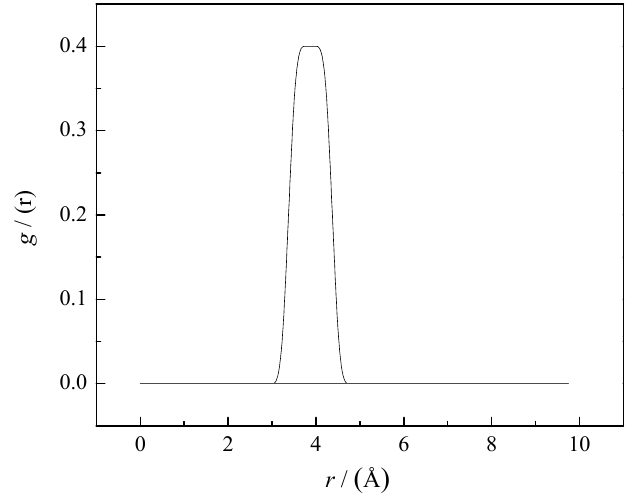
Figure 8. RDFs for caffeine-sodium salicylate center of mass. The lines represent the radial distribution functions obtained from MD simulations’ trajectories. The black line represents RDF for caffeine-sodium salicylate center of mass at 0.06 mol · kg − 1 and the red line represents RDF for caffeine-sodium salicylate center of mass at 0.25 mol · kg − 1